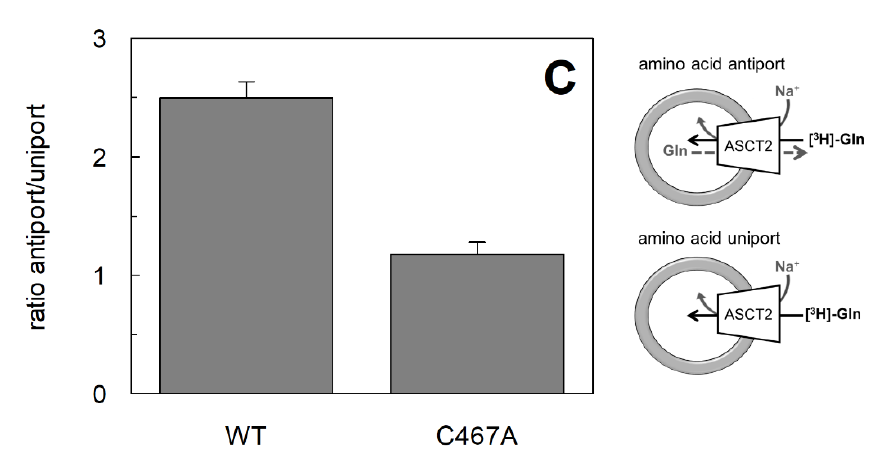
Figure 1. Purification and transport of [ 3 H]-glutamine mediated by ASCT2 WT and C467A mutant in proteoliposomes. In ( A ), Blue-Coomassie staining on SDS-PAGE analysis of recombinant hASCT2 WT and C467A purified in the absence or in the presence of 1 mM glutamine in the desalting buffer, as indicated by “+” and “ − ”. Image is representative of three independent protein preparations. In ( B ), time course analysis of [ 3 H]-glutamine unidirectional transport. The proteoliposomes were re- constituted with WT ( ) or C467A (□, ■ ). The transport was started by adding 500 µM [ 3 H]-glutamine to proteoliposomes prepared without internal glutamine, in the absence ( ■ ) or in the presence ( , □) of 50 mM Na-gluconate. The transport was stopped at indicated times according to the stop inhibitor method. In the figure, sketch of the unidirectional transport. In ( C ), ratio of antiport/uniport reac- tions mediated by WT and C467A reconstituted in proteoliposomes. The transport was started by adding 500 µM [ 3 H]-glutamine and 50 mM Na-gluconate to proteoliposomes prepared without in- ternal glutamine (for the amino acid uniport measurements) or 500 µM internal glutamine (for the amino acid antiport measurements). The transport was stopped after 120 min, i.e., at equilibrium. In the figure, sketch of the amino acid antiport or uniport reaction. In ( B , C ), results are means ± S.D. from three independent experiments.